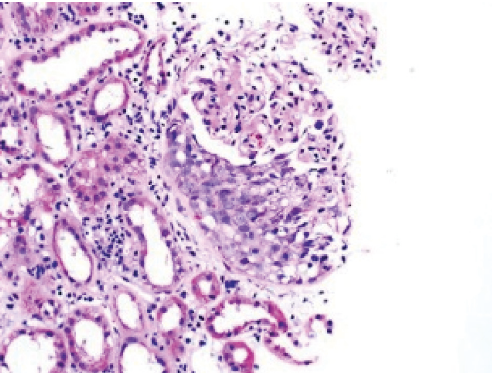
Figure 1: Light microscopy showing a glomerulus with focal segmental fibrinoid necrosis.